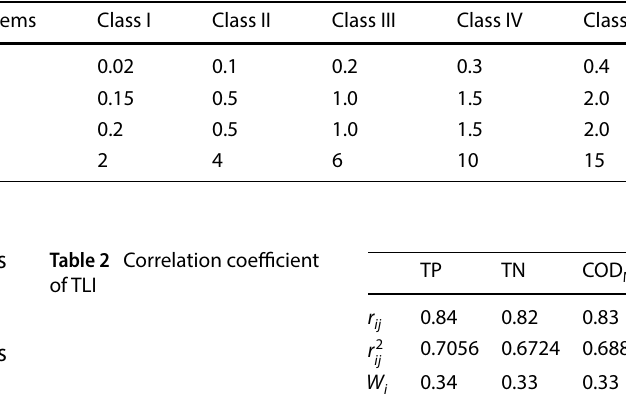
Table 1 Environmental Quality Standard for Surface Water